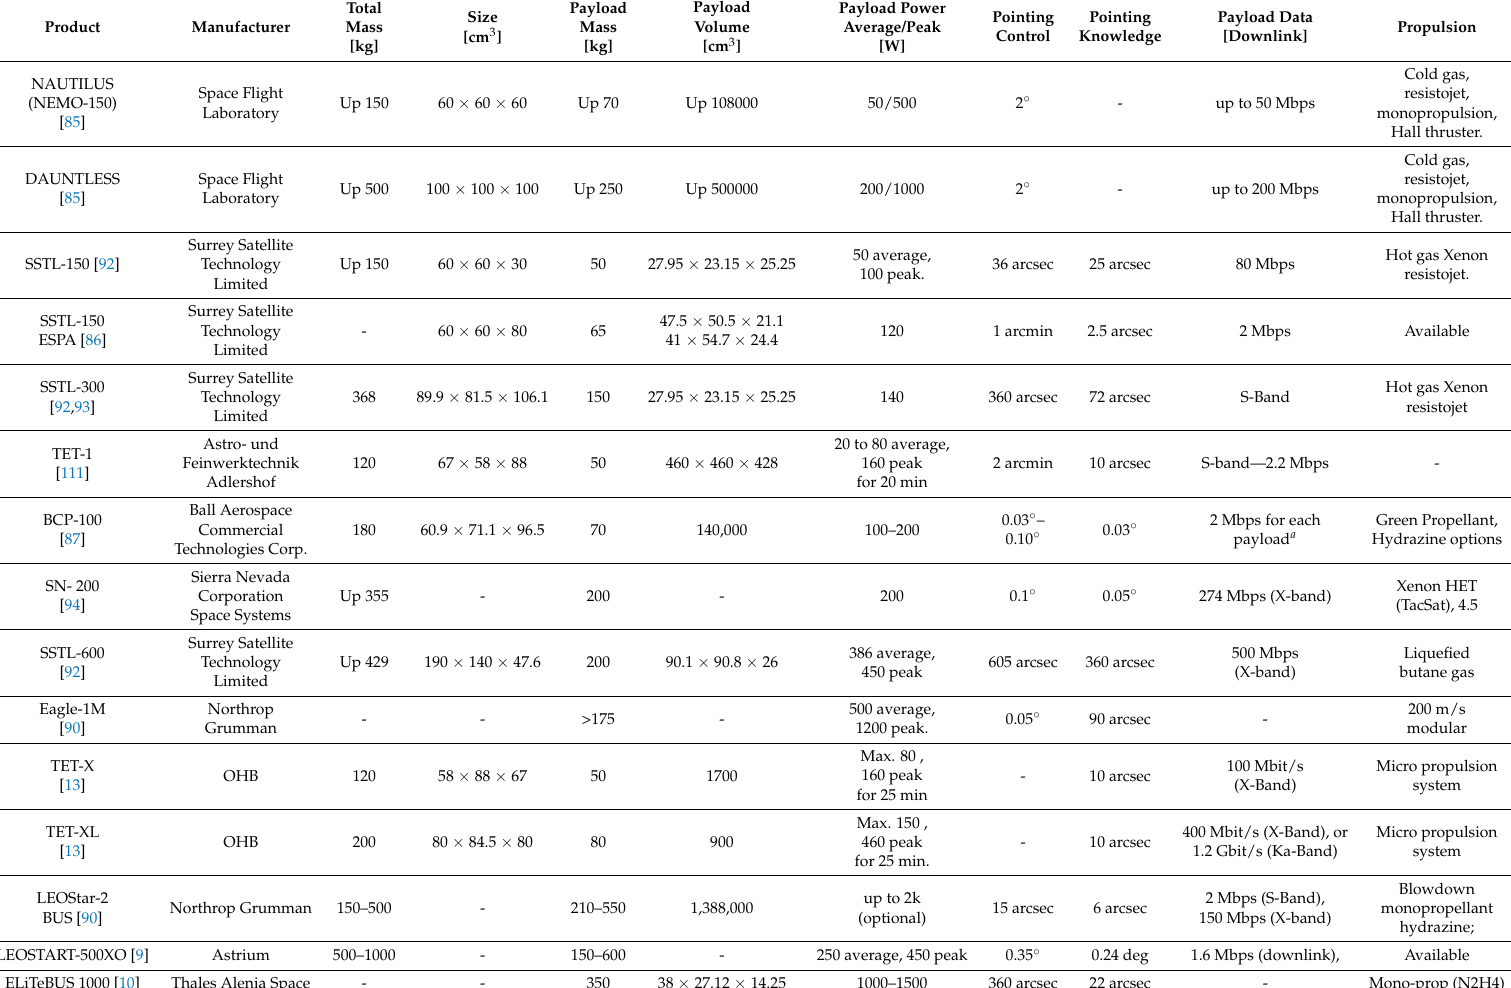
Table A3. Survey of available mini-platforms for Earth